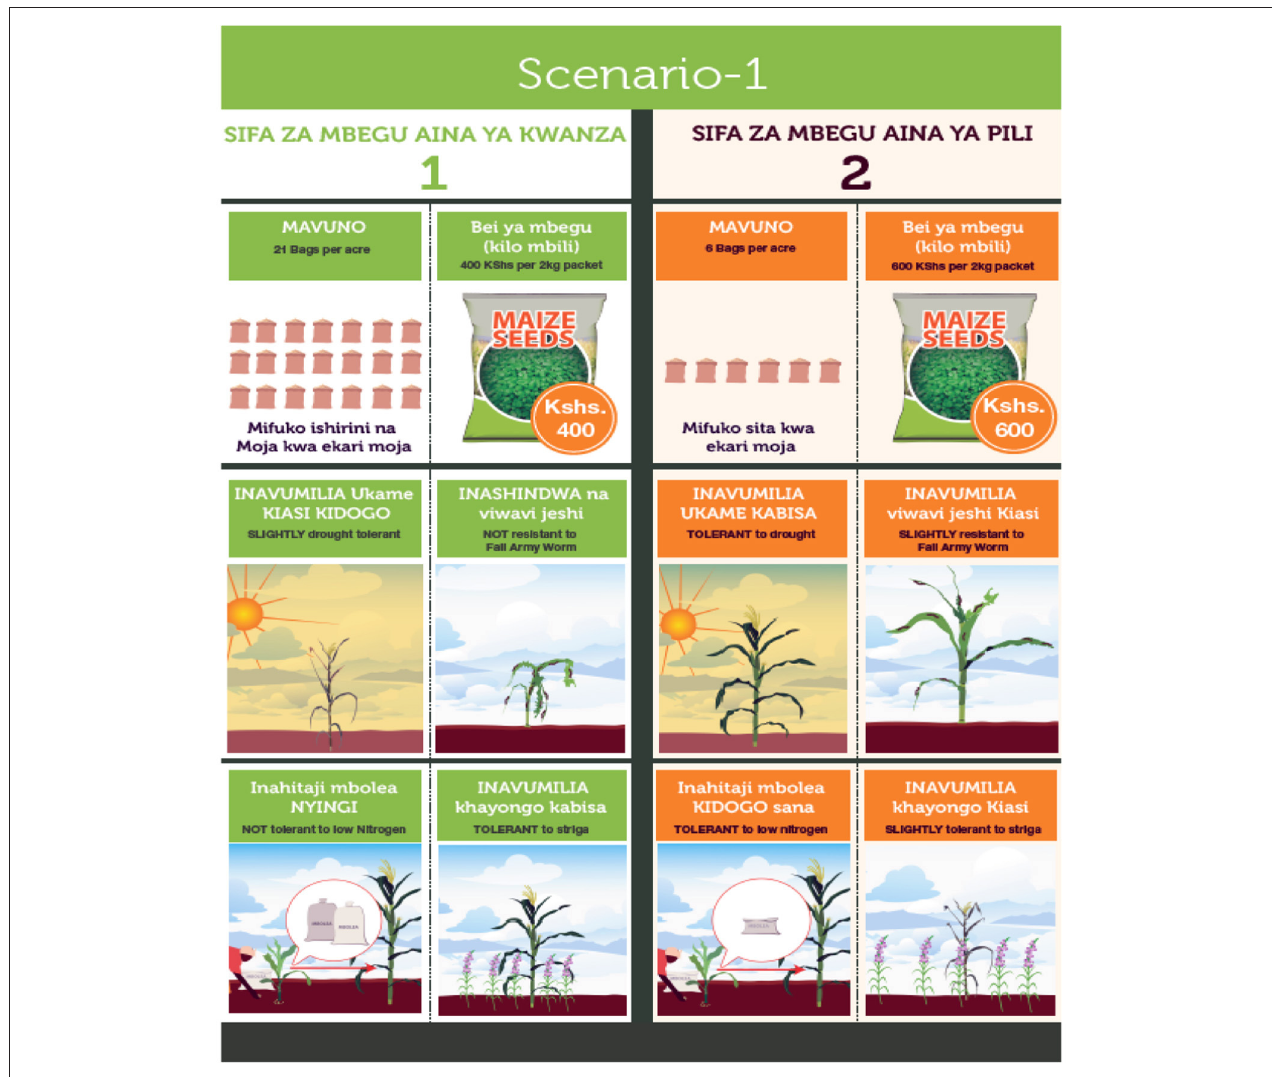
FIGURE 2 | An example of choice experiment session (session 1) comparing traits for two maize